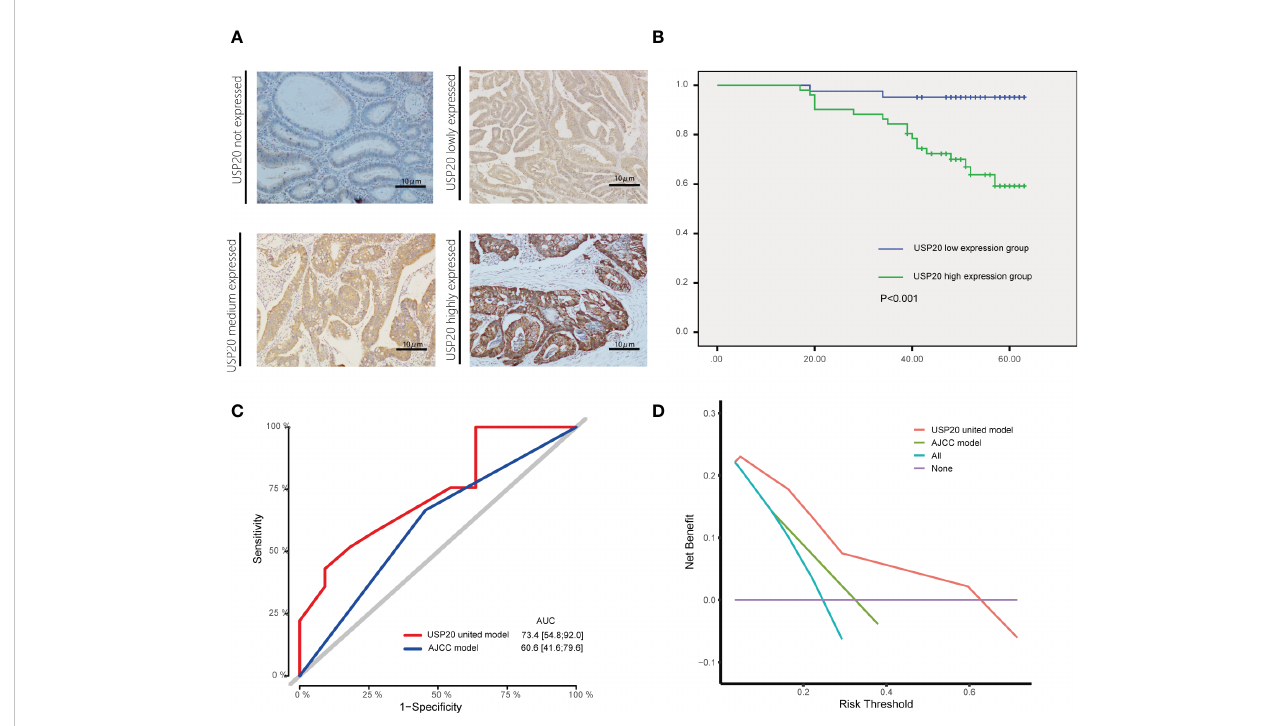
FIGURE 4 Association between USP20 expression and postoperative survival in IHC cohort CRC patients; (A) The USP20 IHC samples were classi fi ed into not expressed, lowly expressed, medium expressed and highly expressed categories; (B) The Kaplan-Meier(KM) method was used to compare the relationship between different USP20 expression levels and the overall survival of patients; (C) The receiver operating characteristic (ROC) curve analysis was used to evaluate the prognostic validity of the USP20 joint model and AJCC model; (D) The decision curve analysis(DCA) was used to estimate the clinical usefulness and net bene fi t of USP20 joint model and AJCC model.